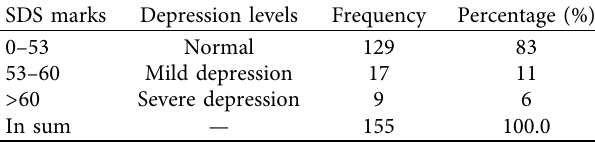
Table 2: The surveyed students’ SDS marks and depression